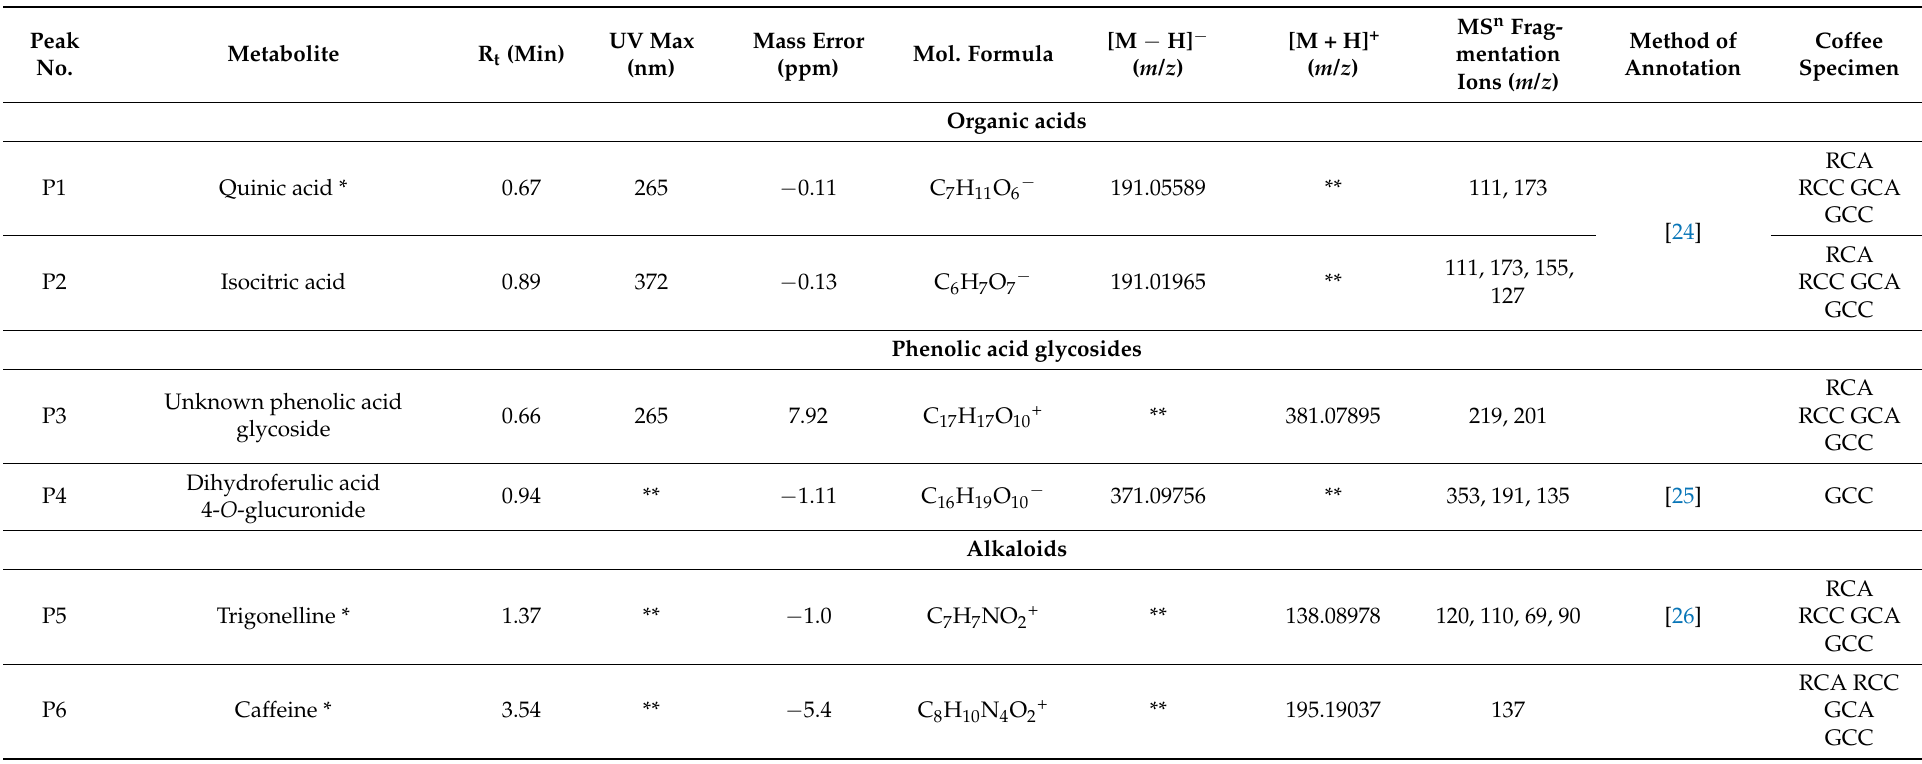
Table 2. Metabolites identified in methanol extracts of authenticated green C. robusta (GCC), green C. arabica (GCA), roasted C. robusta (RCC), and roasted C. arabica (RCA) via UHPLC-PDA-ESI–HRMS in both negative and positive ionization modes. Annotation of detected peaks was based on previous literature, retention times, tandem MS, and molecular